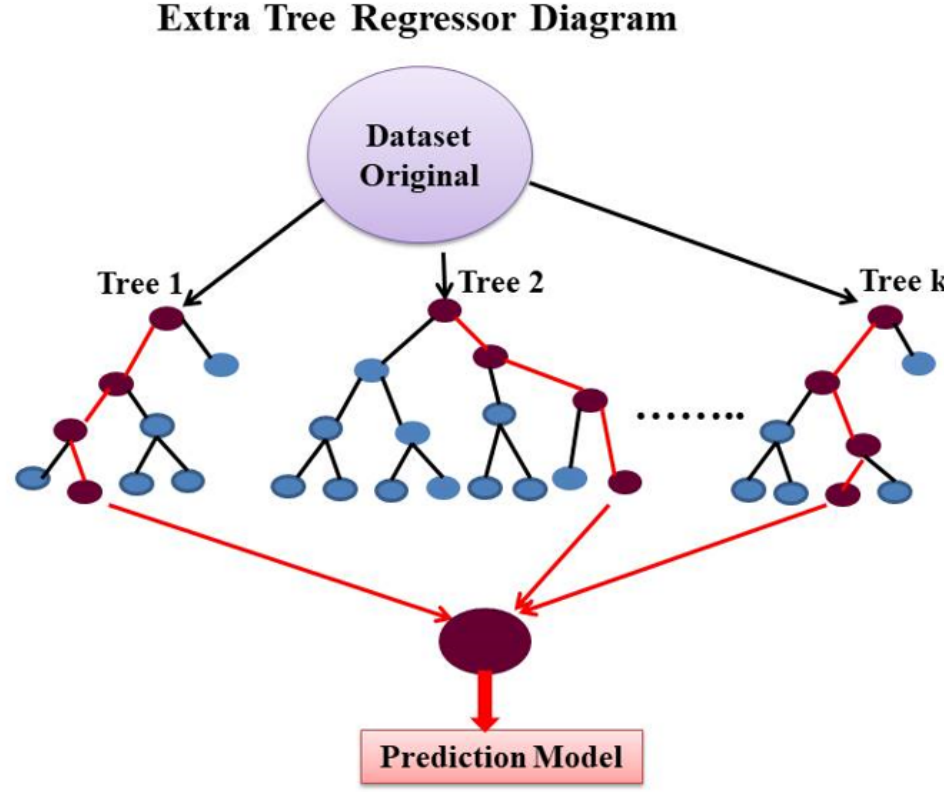
Figure 4. Schematic diagram of Extra Tree Regressor.